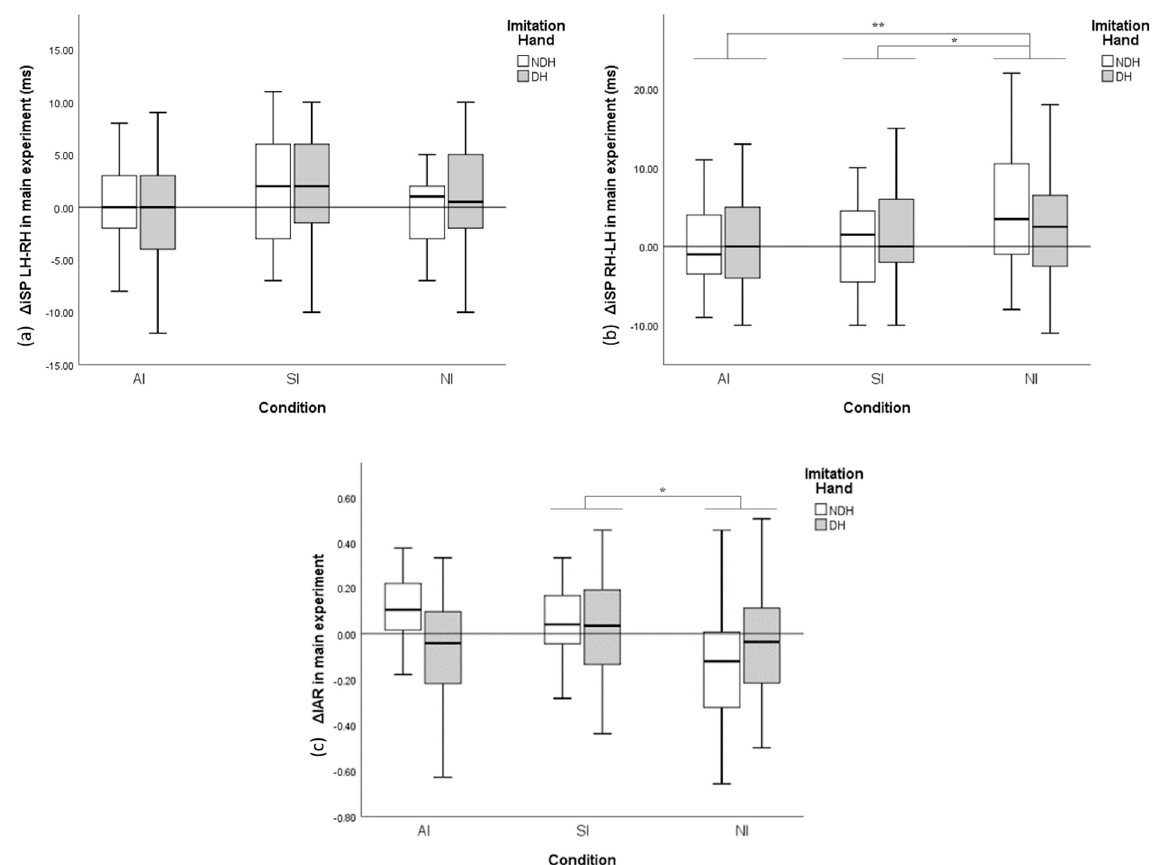
Figure 4. Variance ( ∆ ) of bidirectional ipsilateral silent period (iSP) duration and interhemispheric asymmetry ratio (IAR) compared with baseline during the main experiment. ( a ) ∆ iSP LH–RH with different conditions and imitation hands. ( b ) ∆ iSP RH–LH with different conditions and imitation hands. ( c ) ∆ IAR with different conditions and imitation hands. The y-axis of A and B display the duration variance of iSP, with positive values indicating iSP (IHI) increase and negative values indicating iSP (IHI) decrease. The y-axis of C indicates the variance of IAR. Error bars represent a 95% confidence interval (CI). * p < 0.05; ** p < 0.01.